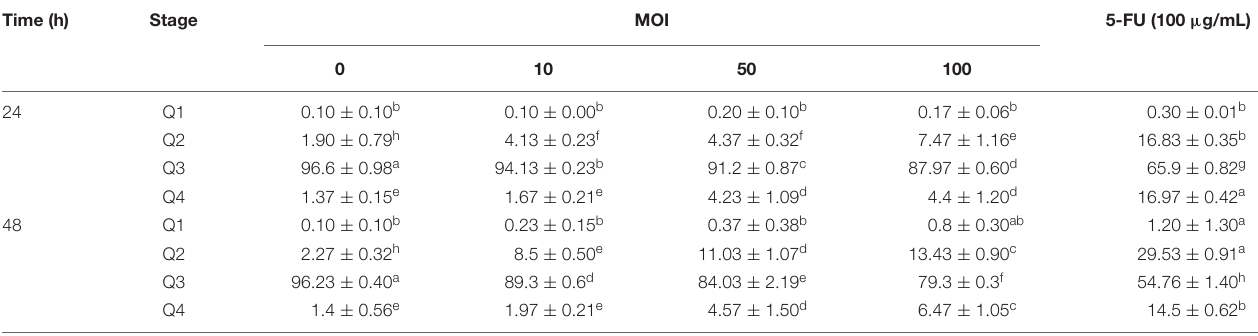
TABLE 1 | Effect of L. acidophilus KLDS1.0901 on apoptosis of HT-29 cells. Time (h)